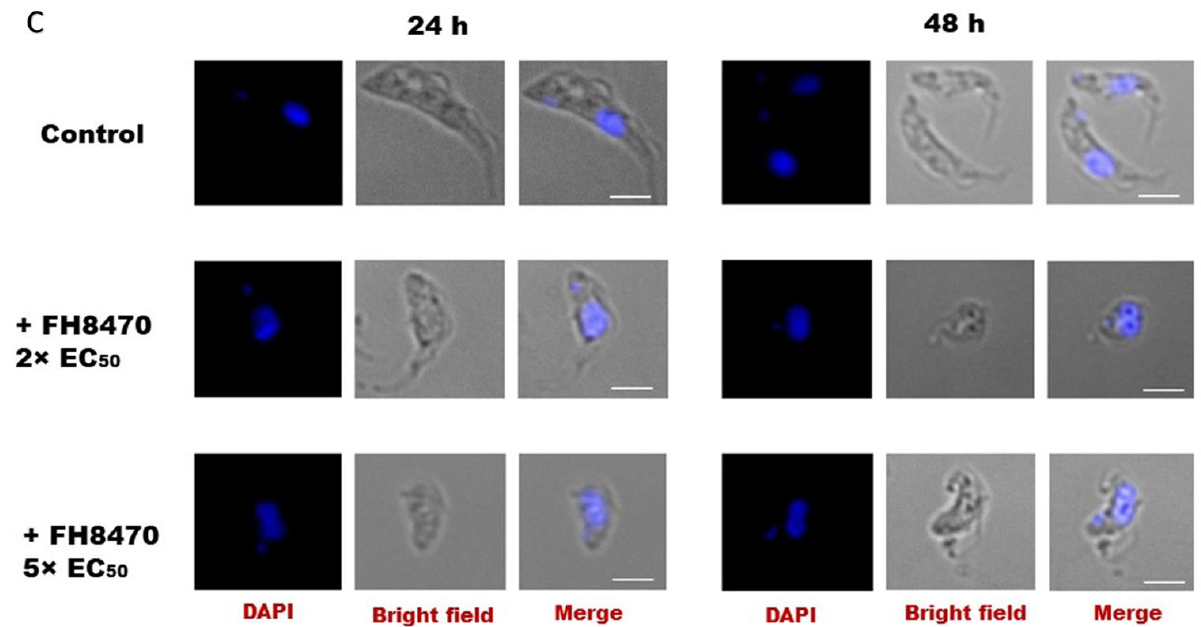
Figure 11. The effect of tubercidin analog FH8470 on growth, cell cycle and morphology of T. con- golense. ( A ) Manual cell count of cultures grown in the presence or absence of 5 × or 15 × EC 50 of tubercidin analog FH8470. For short exposure, cultures were washed through centrifugation and resuspended in fresh medium. The dotted brown line indicates the detection limit, being 10 4 cells/mL. For the purpose of this graphical representation, where no cells were observed in the counting chamber, the value of 5 × 10 3 or 4 × 10 3 was entered. ( B ) Effect of nucleoside analog FH8470 on the cell cycle progression in T. congolense . Cells were seeded at 10 5 cells/mL in growth medium with or without test drug at the desired concentration. At each predetermined period, approximately 10 6 cells were harvested, transferred to a glass slide and fixed. The slide was then DAPI-treated and covered with a coverslip, and images were acquired using Olympus IX71 DeltaVision Core System fluorescent microscope (Applied Precision, GE, Raˇca, Slovakia). The configurations of nucleus and kinetoplast for at least 300 cells were observed in each group; 1K1N = one kinetoplast and one nu- cleus; 2K1N = two kinetoplasts and two nuclei; 2K2N = two kinetoplasts and two nuclei; MKMN = multiple kinetoplasts and/or nuclei; other = other aberrations such as no nucleus or no kinetoplast. Graphs show percentage mean ± SEM of three independent determinations. ( C ) Images of T. congo- lense cells exposed to nucleoside analog FH8470 for 24 h or 48 h. Test drug at desired concentration was added to BSF T. congolense culture followed by incubation for 24 h or 48 h. Cells were harvested at predetermined point, applied to a glass slide, fixed and treated with DAPI before the slide was covered with a coverslip. Images were acquired using a Delta Vision Core fluorescent microscope and analyzed using ImageJ software. Treated culture showed higher percentage of cells with con- joined nuclei and two kinetoplasts, often accompanied by mottled cell surface and loss of slender BSF shape. White bar represents 3 µM.